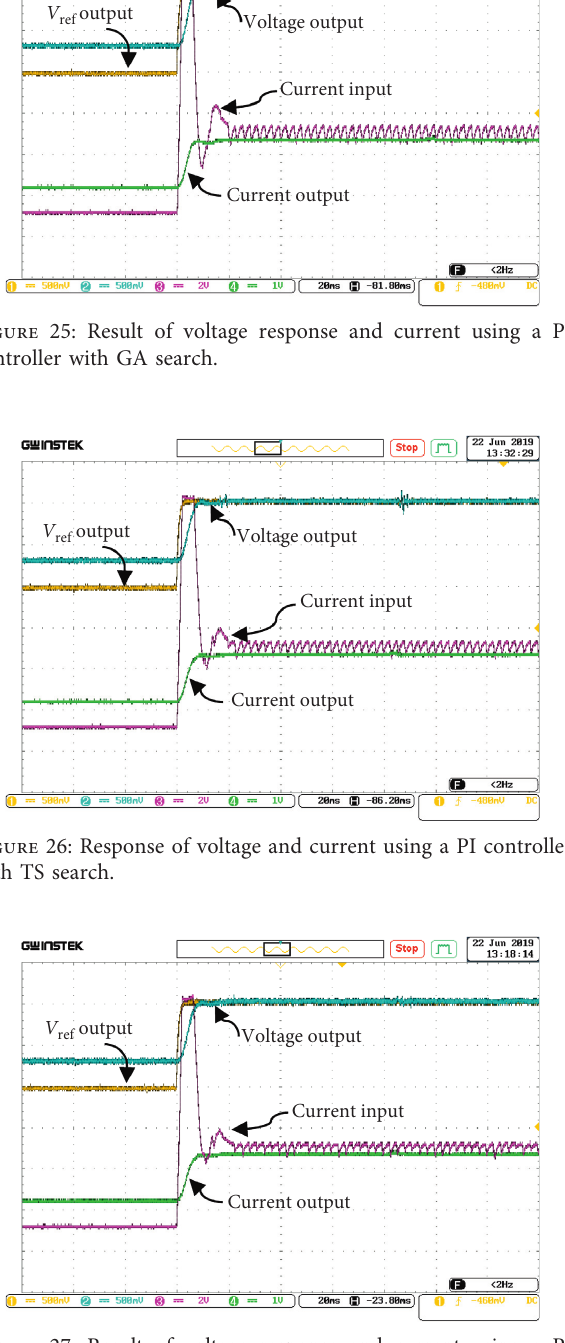
Figure 27: Result of voltage response and current using a PI controller with PSO search.